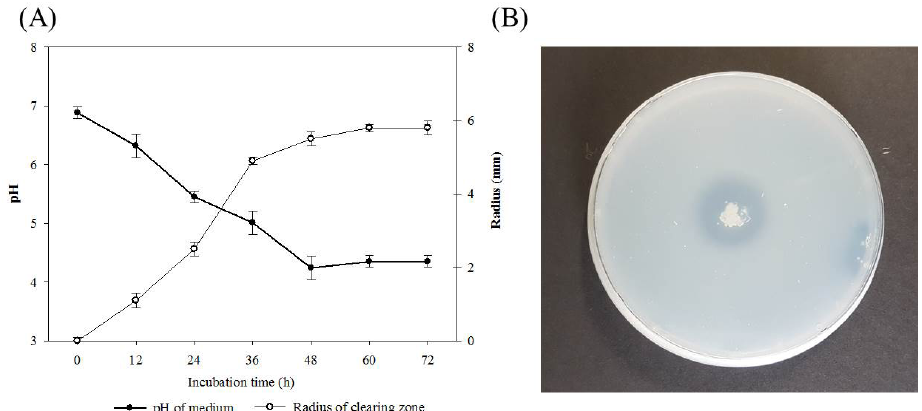
Fig. 1: (A) The rate of halos formation of B. subtilis JW1 in liquid NBRIP medium and pH of the medium. Values given are means of three replicates and error bars indicate standard deviation (B) the corresponding B. subtilis JW1on NBRIP growth media plates after 72 hours of incubation at 30 °C.